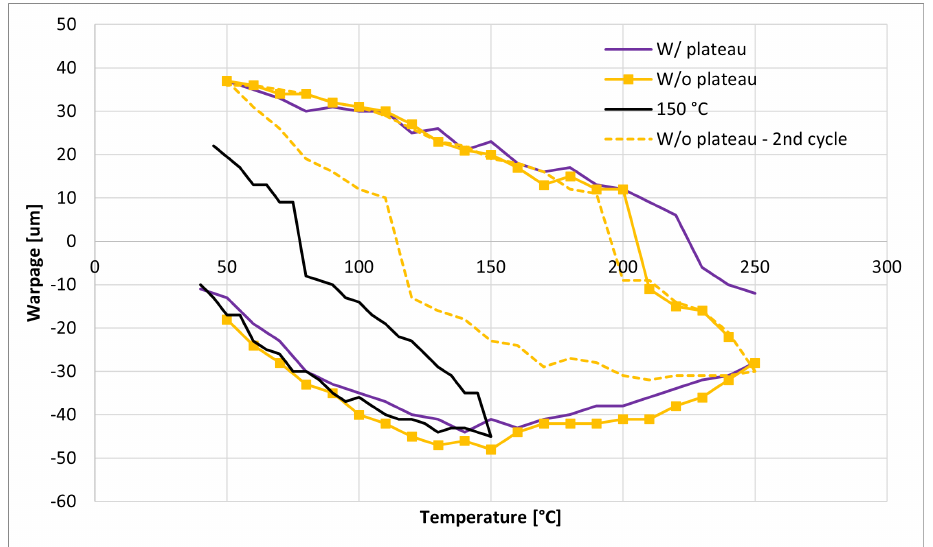
Figure 5. Measured warpage during temperature profiles. Negative values are reached during the heating, while positive ones during the cooling phase. Dotted line represents the warpage versus temperature profile that occurred during a second temperature